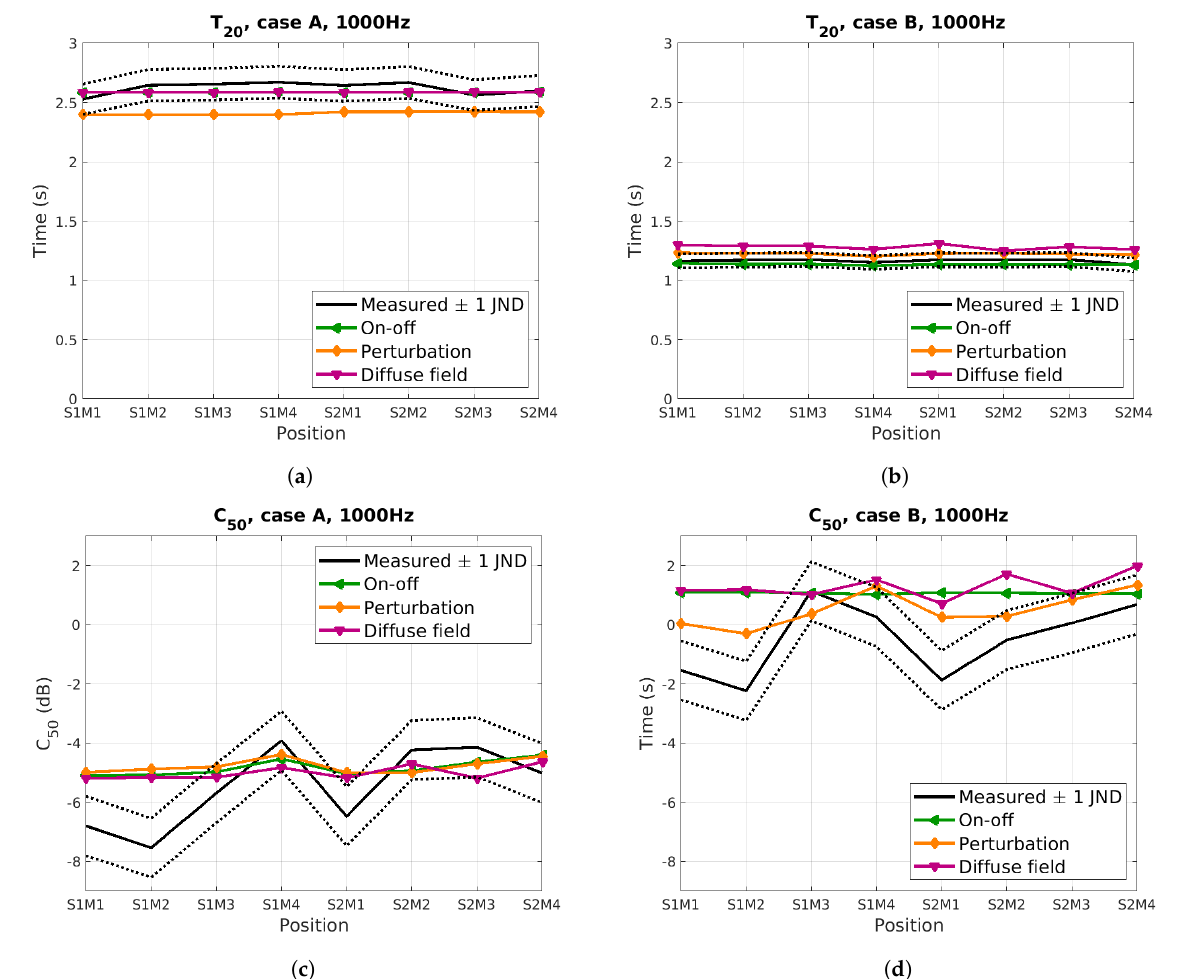
Figure 6. Measured and simulated T 20 ( a , b )and C 50 ( c , d ) for the octave band centered on 1000 Hz, for each source and listener position. There are only small spatial variations for the reverberation time, which is consistent with theory. Similarly to the results seen for spatially averaged measurements, the perturbation algorithm is inaccurate in case A and the diffuse field algorithm in case B. For C 50 , the measured spatial variations are larger. The variations in the simulated results are